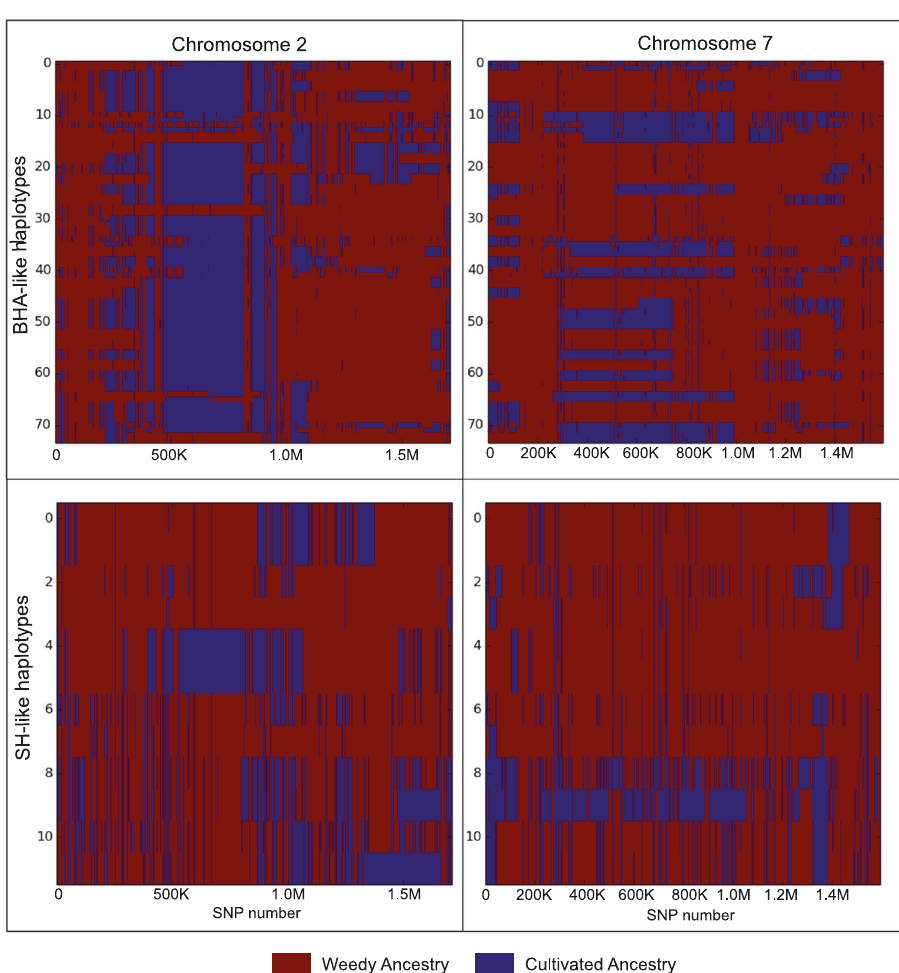
Fig. 4 Local ancestry estimations across chromosomes 2 and 7. Local ancestry estimations based on Loter analysis across two rice chromosomes (2, 7) for each of two populations of hybrid-derived weedy rice. Each haplotype is plotted horizontally across the relevant chromosome. Blue areas denote crop- like regions of the genome, while red areas represent weed-like